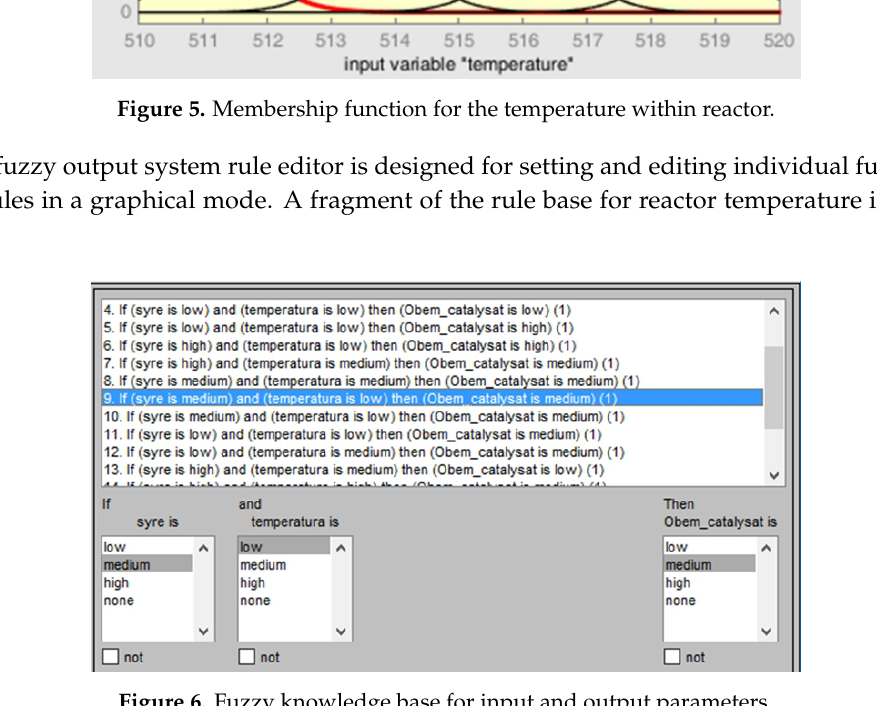
Figure 6. Fuzzy knowledge base for input and output parameters.